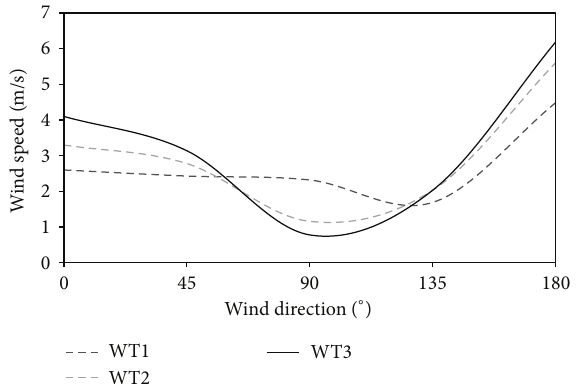
Figure 13: Numerical relationship between extracted wind velocity and wind direction.